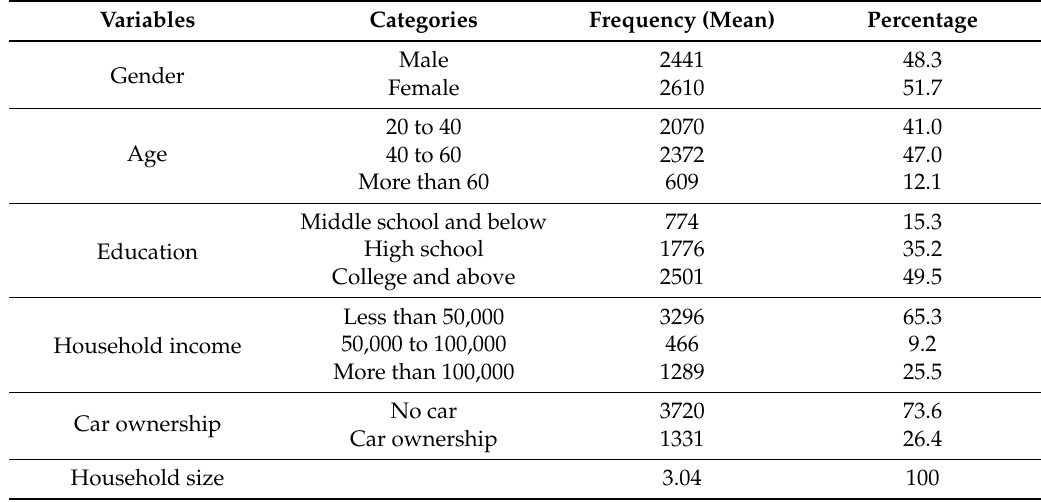
Table 2. Profile of the sample.